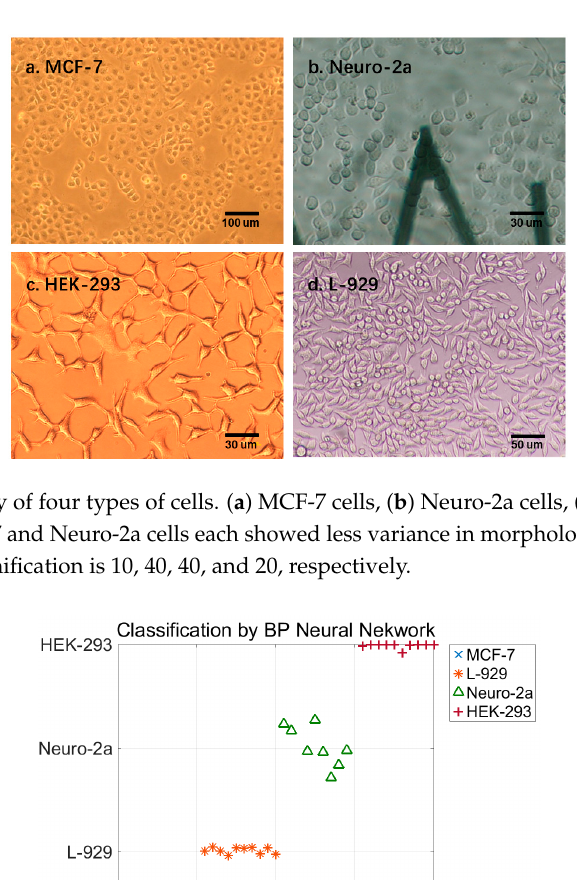
Figure 5. Principle components for four types of cells. These three plots show the first component vs. the second component, the first component vs. the third component, and the second component vs. the third component.